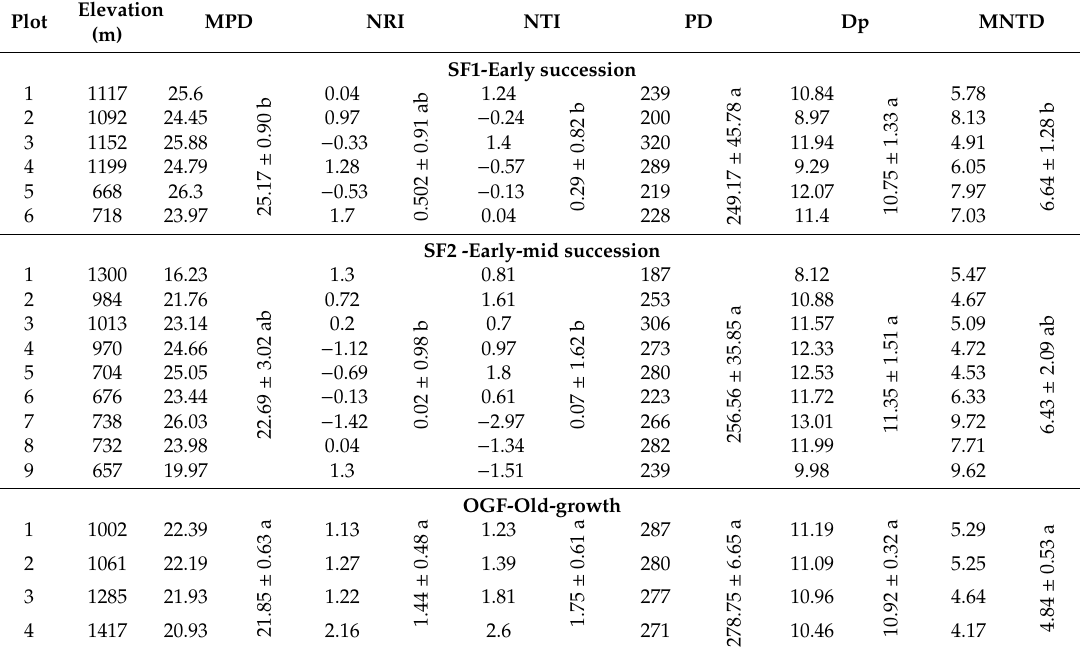
Table 2. Phylogenetic structure and diversity of the three forest types (mean ±